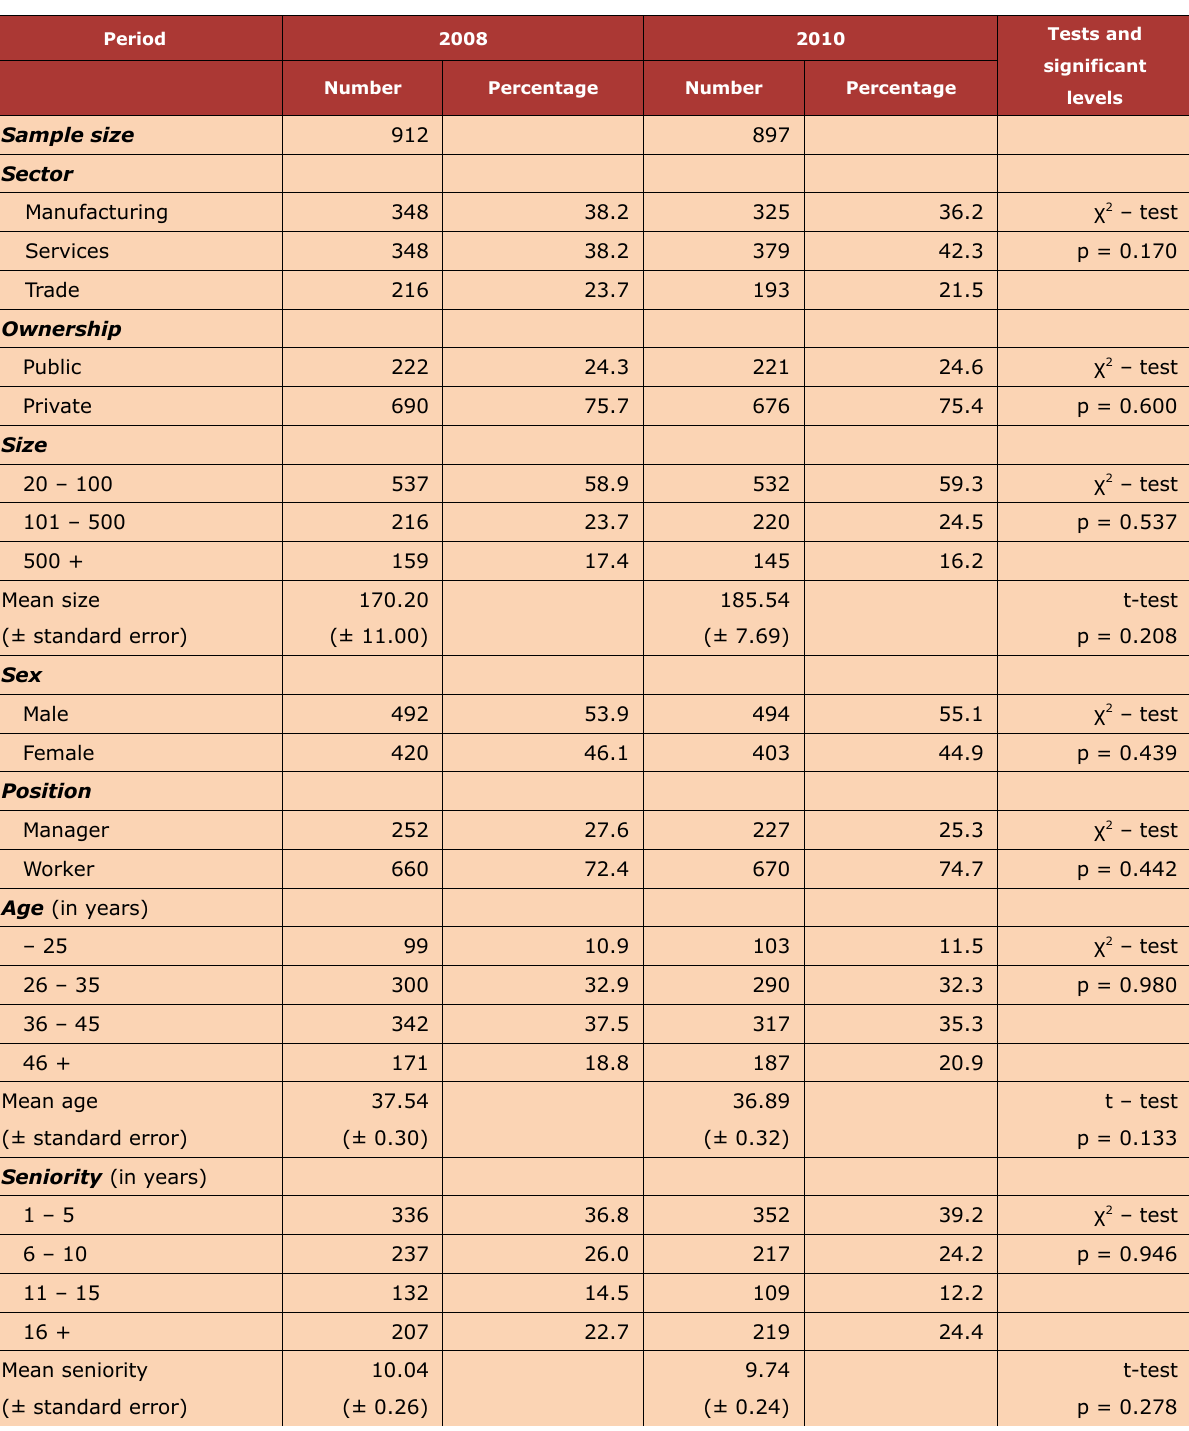
Table 2. Sample demographics with respect to